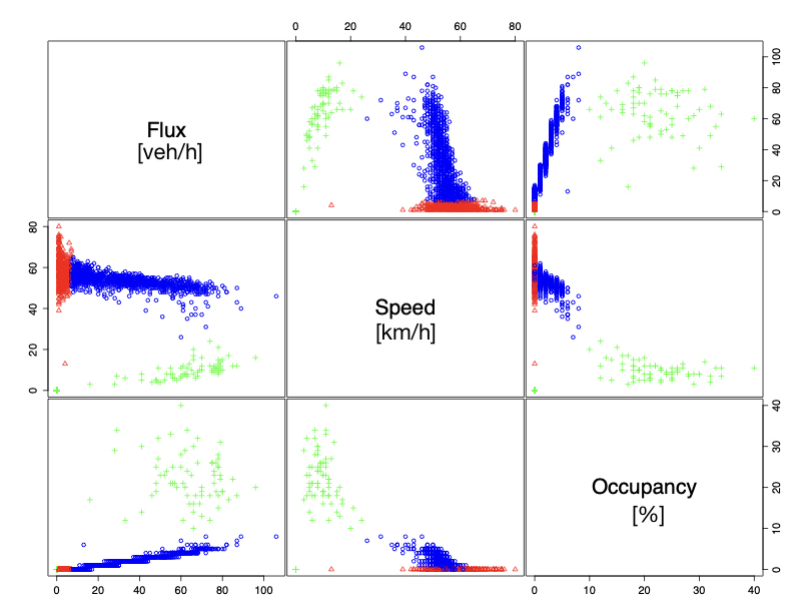
Figure A5. Pairs plot of clustered Sophia Antipolis